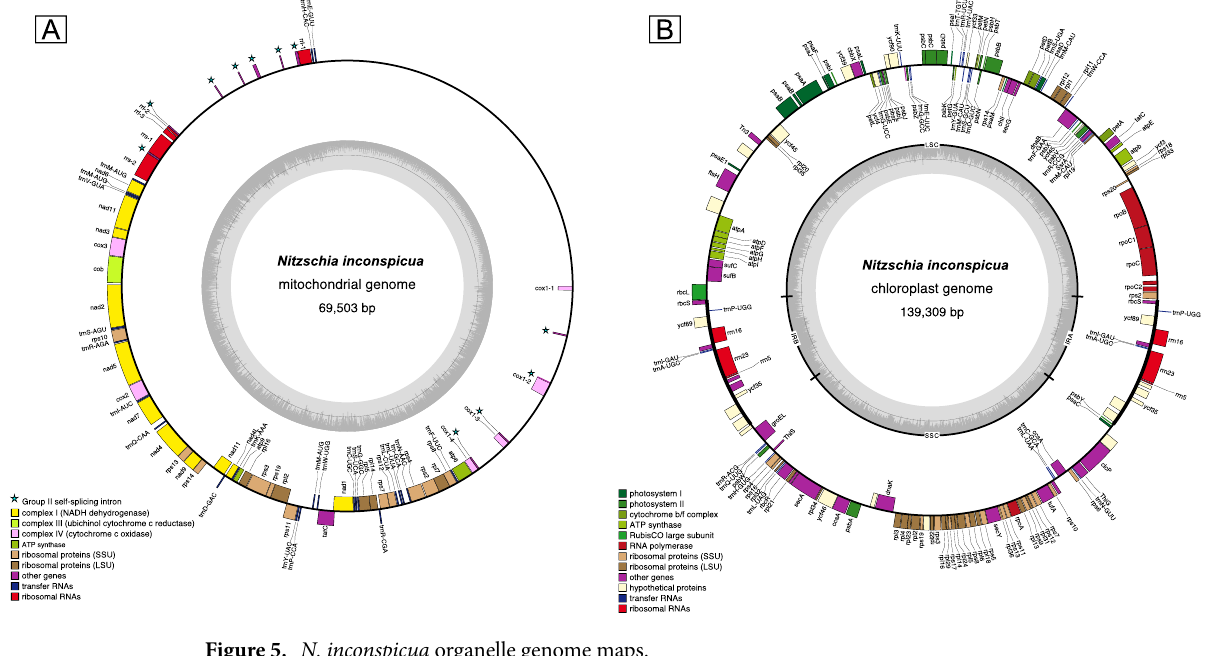
Figure 5. N. inconspicua organelle genome